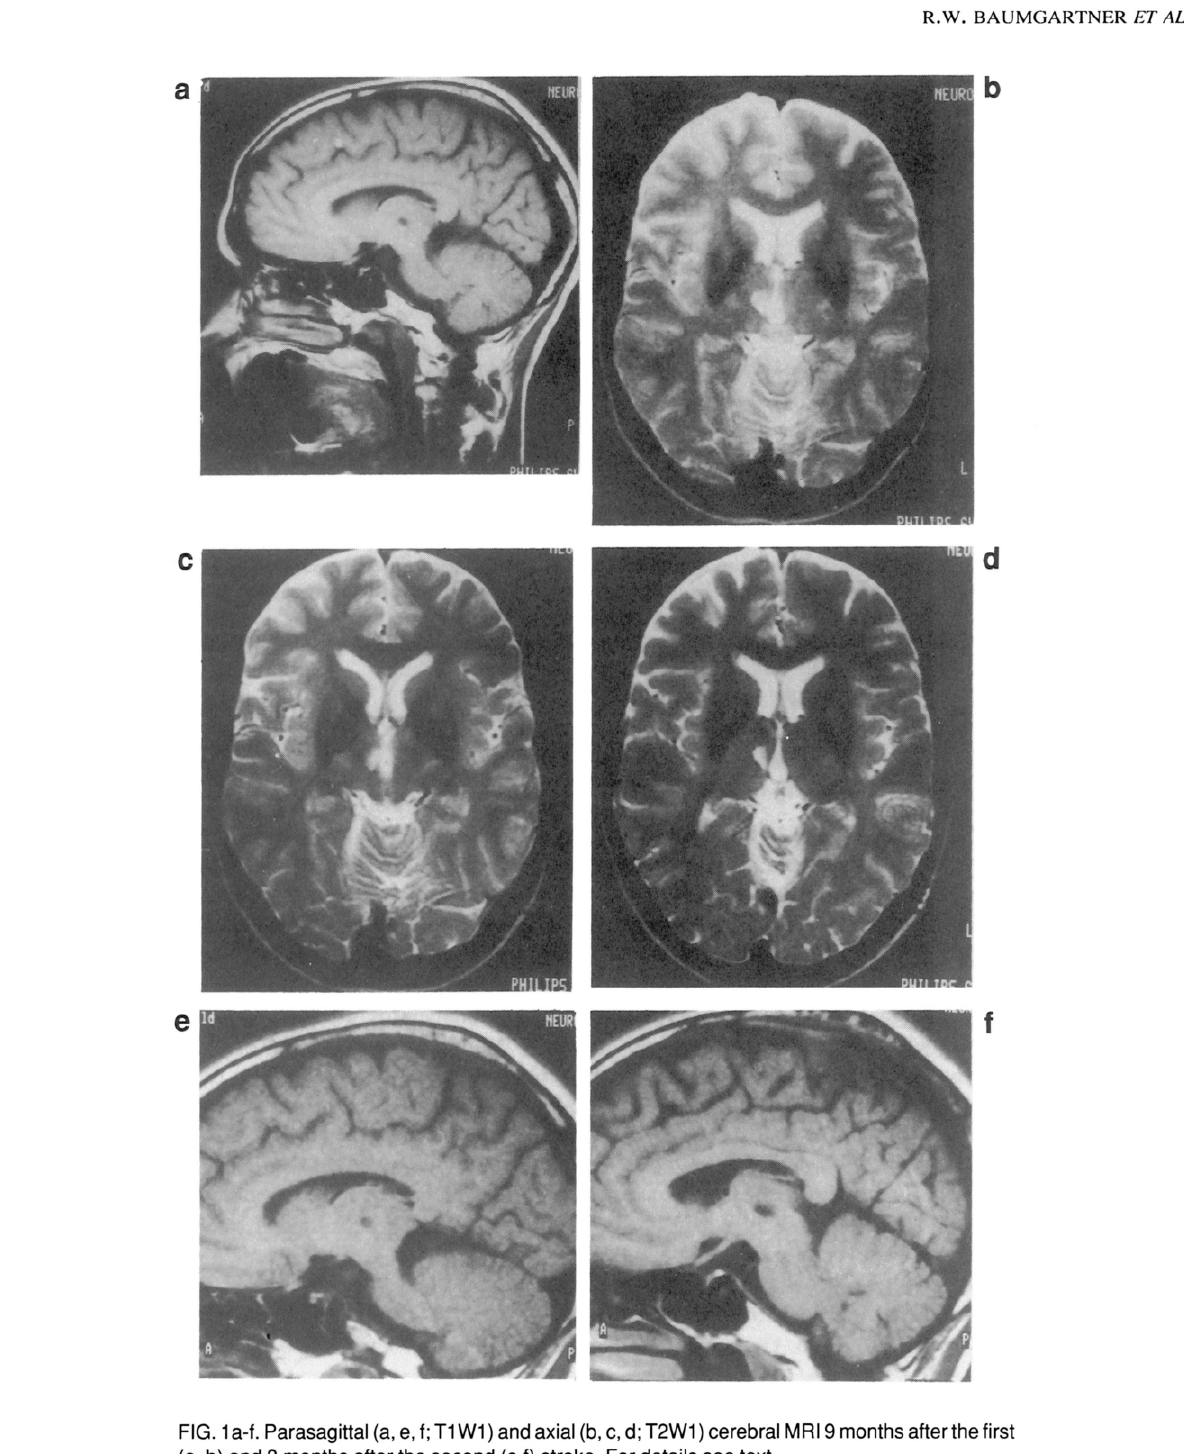
FIG. 1 a-f. Parasagittal (a, e, f; T1 W1) and axial (b, c, d; T2W1) cerebral MRI9 months after the first (a, b) and 3 months after the second (c-f) stroke. For details see text. same symptoms recurred acutely. Neurological examin ation showed again only an area of diminished sensation over the left face. Neuropsychological examination dem onstrated unchanged mild memory disturbances for verbal and figural material, a marked reduction in figural fluency (Regard et al., 1982) but an excellent verbal fluency. Behavioural Neurology. Vol 5 . 1992